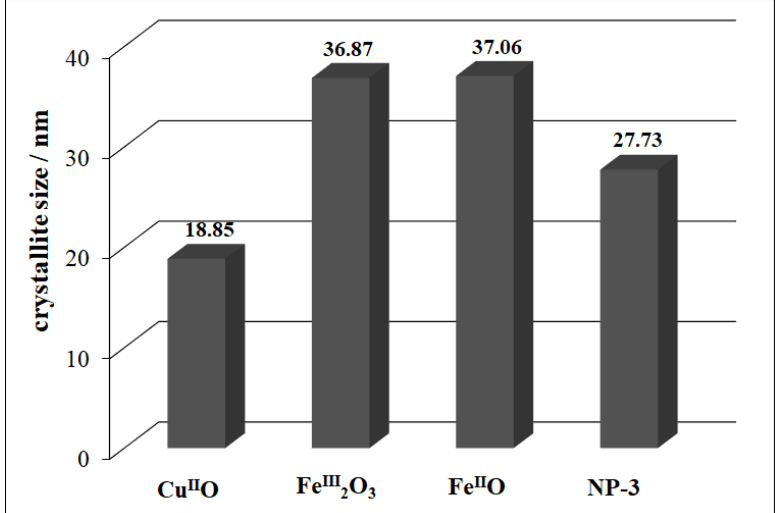
Figure 4. Comparison of the average crystallite sizes of simple metal oxides and NP-3. The detailed DRS spectra were recorded for all metal oxide and ferrite NPs. The band-gap energy (E bg ) for all of the synthesized NPs were investigated by applying the Kubelka–Munk function (Figure S4). Cu II O rendered the lowest band-gap energy (1.04 eV) followed by Fe III 2 O 3 (1.94 eV) and finally Fe II O (2.06 eV) (Figure 5).